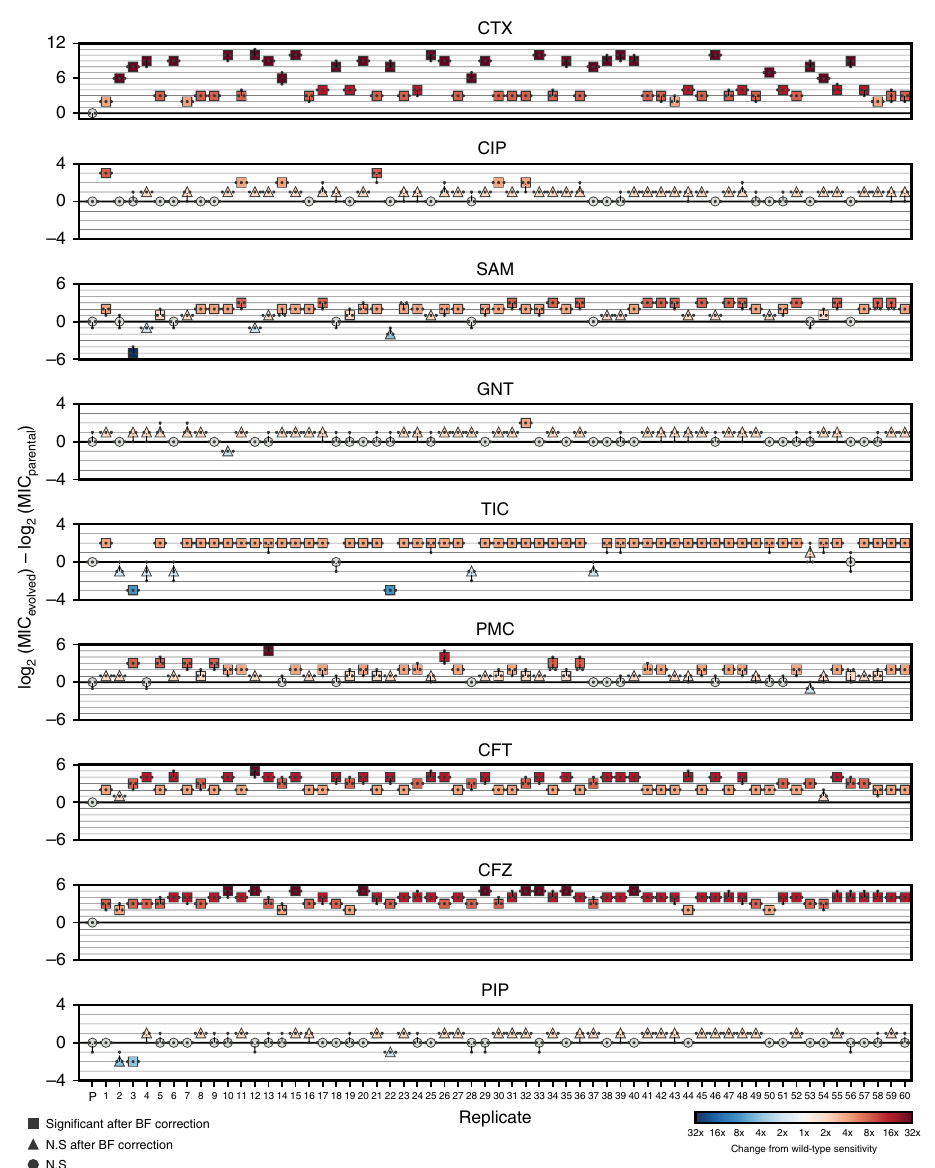
Fig. 4 Collateral response following evolution under cefotaxime. The maximum likelihood estimates for the MICs of replicates X1 – X60 under cefotaxime and eight other antibiotics. Small markers indicate individual measurements (taken in triplicate). Marker colour indicates fold-change from wild-type sensitivity (increased sensitivity — blues, increased resistance — reds). Signi fi cance is determined via a likelihood ratio test (see Methods) and Bonferroni (BF) corrected. Precise p values are reported in Supplementary Dataset